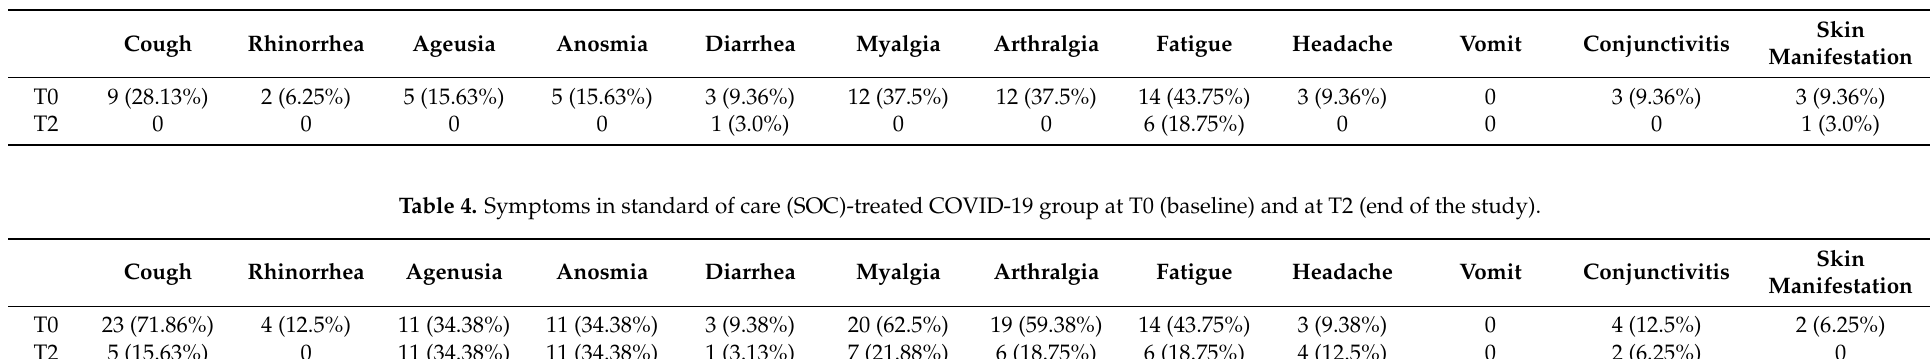
Table 3. Symptoms in liposomal bovine lactoferrin (bLf)-treated COVID-19 group at T0 (baseline) and at T2 (end of the study).